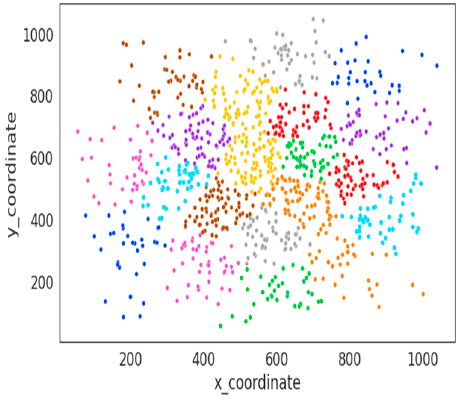
Figure 6. Number of